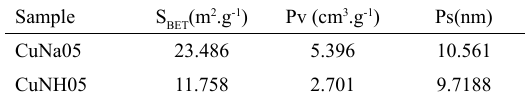
Table 2. Textural characteristics of CuNa05 and CuNH05